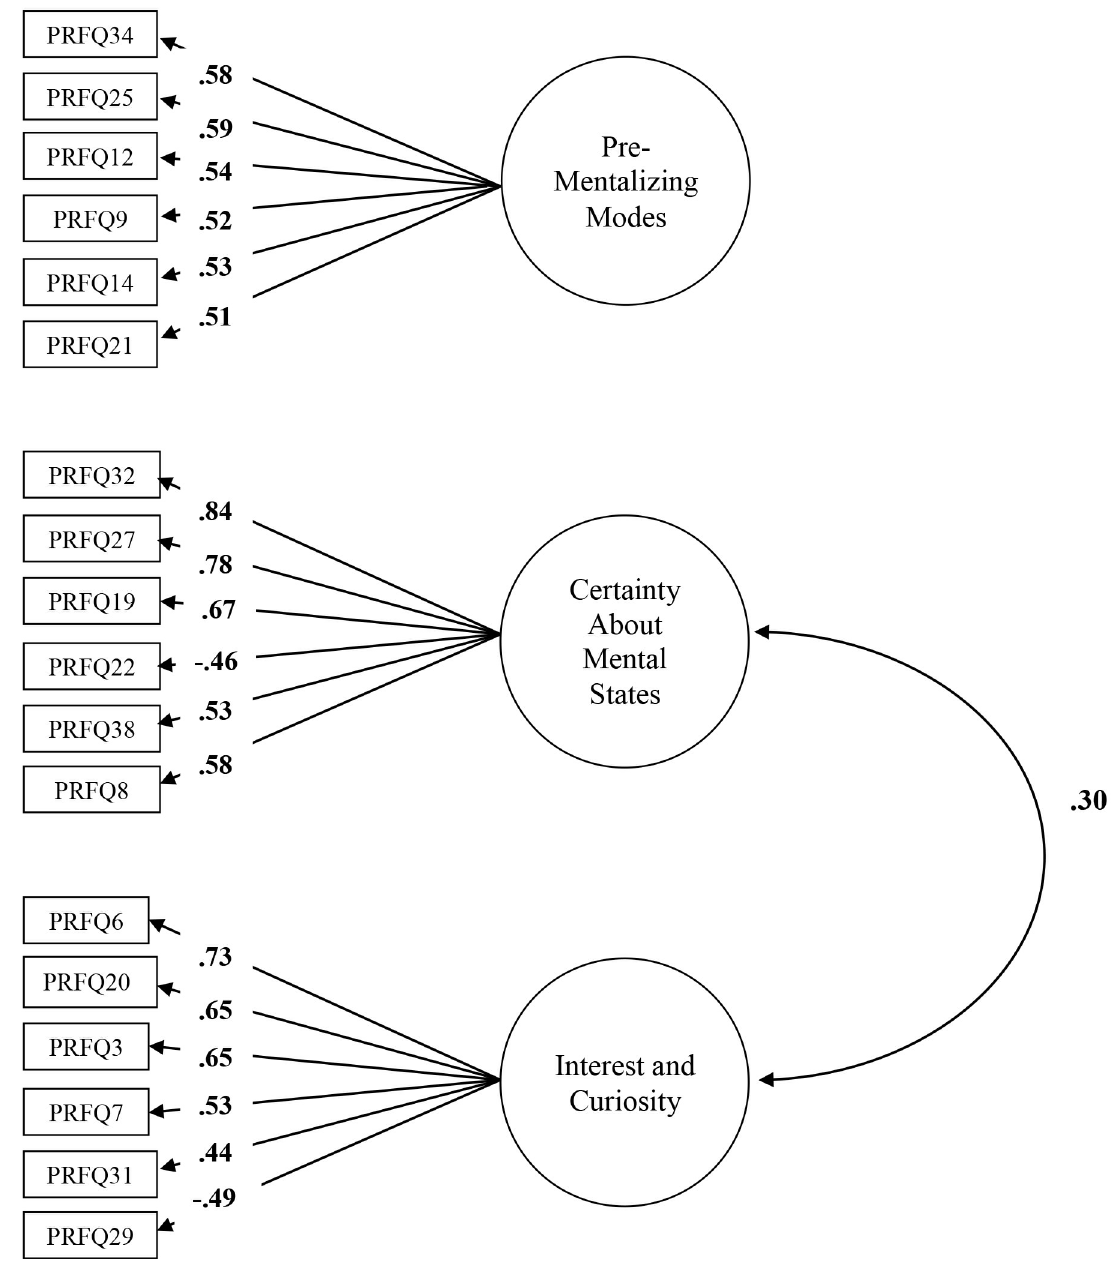
Fig 1. CFA in Study 1. Residualsand correlationsbetweenresidualsare omitted for clarity of presentation. Rectanglesindicate measuredvariablesand circles represent latent constructs. Standardizedmaximum likelihoodparameters are used. Bold estimates are statistically